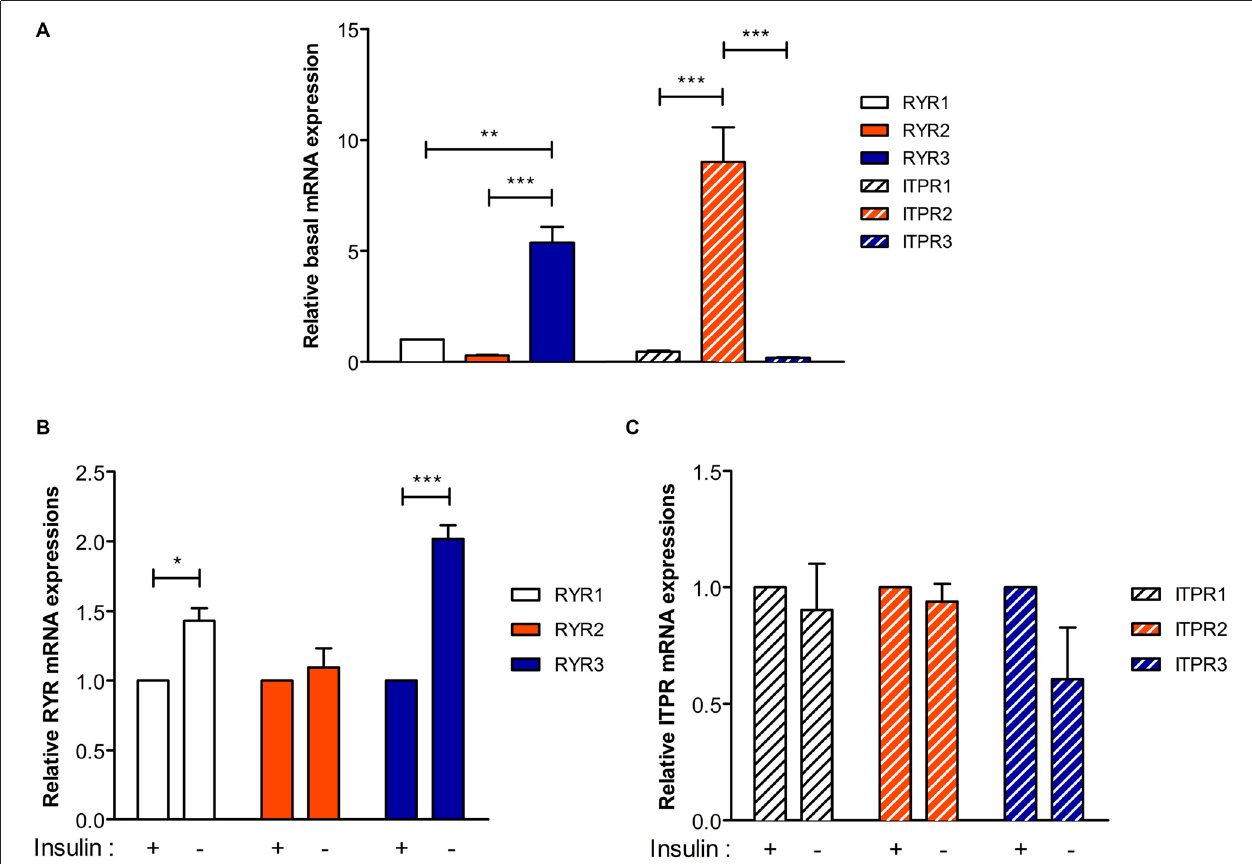
FIGURE 2 | Type 3 Ryanodine receptor (RyR) is the major isoform in HCN cells and its expression is upregulated following insulin withdrawal. (A) Real-time quantitative PCR analysis of basal expression levels of RyR and IP 3 R genes denoted as RYR and ITPR, respectively, after normalization to β -actin. (B,C) A change in the mRNA levels of RYR (B) and ITPR (C) 24 h following insulin withdrawal. Each set of experiment was conducted in triplicate per experiment ( n = 4). The bars represent the mean ± SEM; ∗ p < 0.05, ∗∗ p < 0.01, ∗∗∗ p <